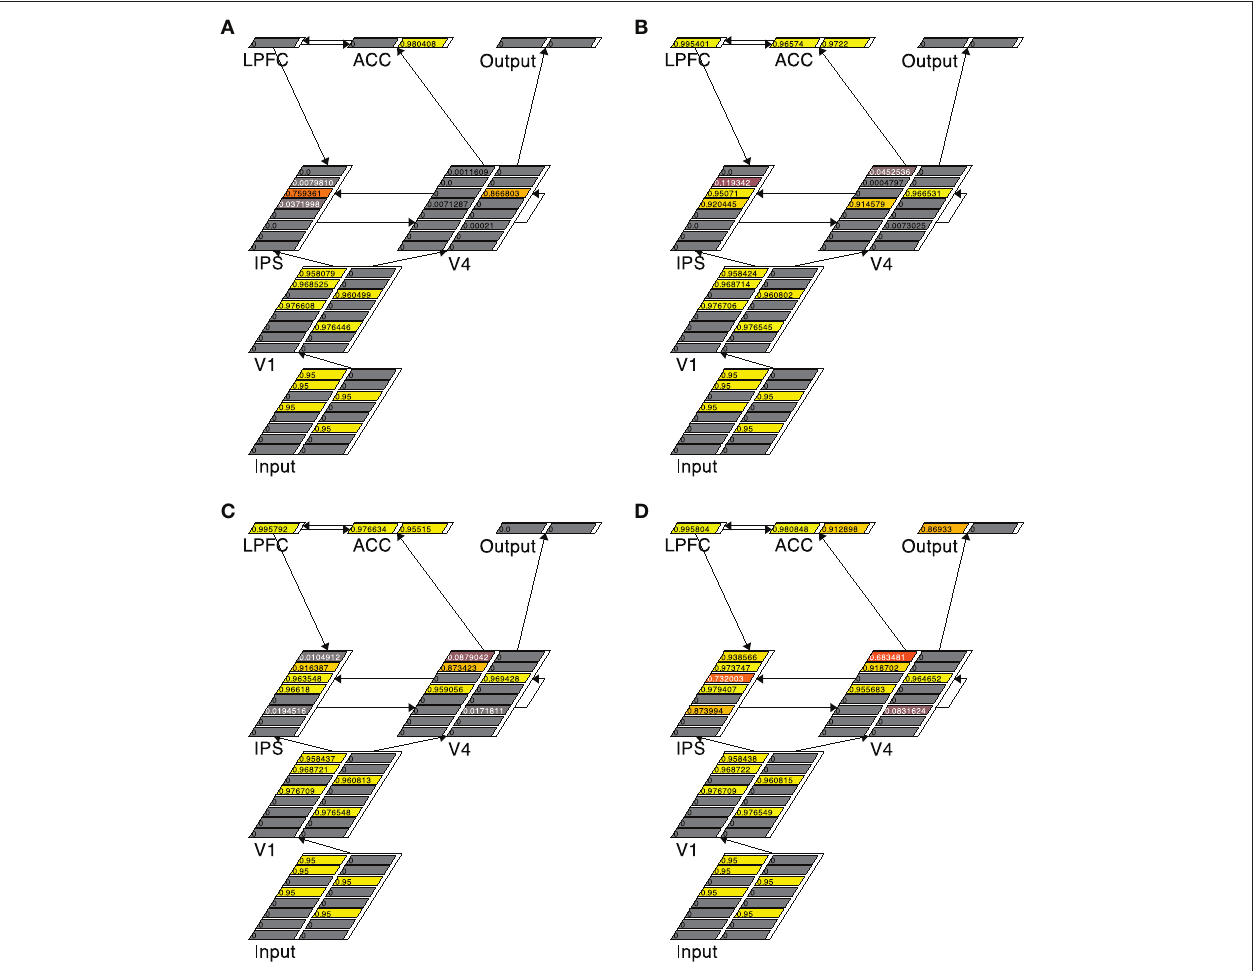
Figure 5 | Traces of the self-terminating search model running in a trial with three left-pointing and two right-pointing arrows, at four different time points: cycle 40 (A), cycle 61 (B), cycle 76 (C), and cycle 90 (D) . Note that the persistent activity in the IPS layer in the face of incongruity in the sample is mainly due to the dynamics generated by increasing k during the